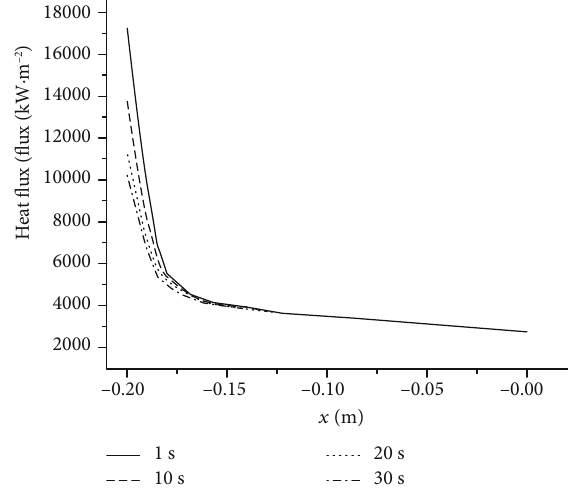
Figure 15: Heat fl ux distribution along the surface.